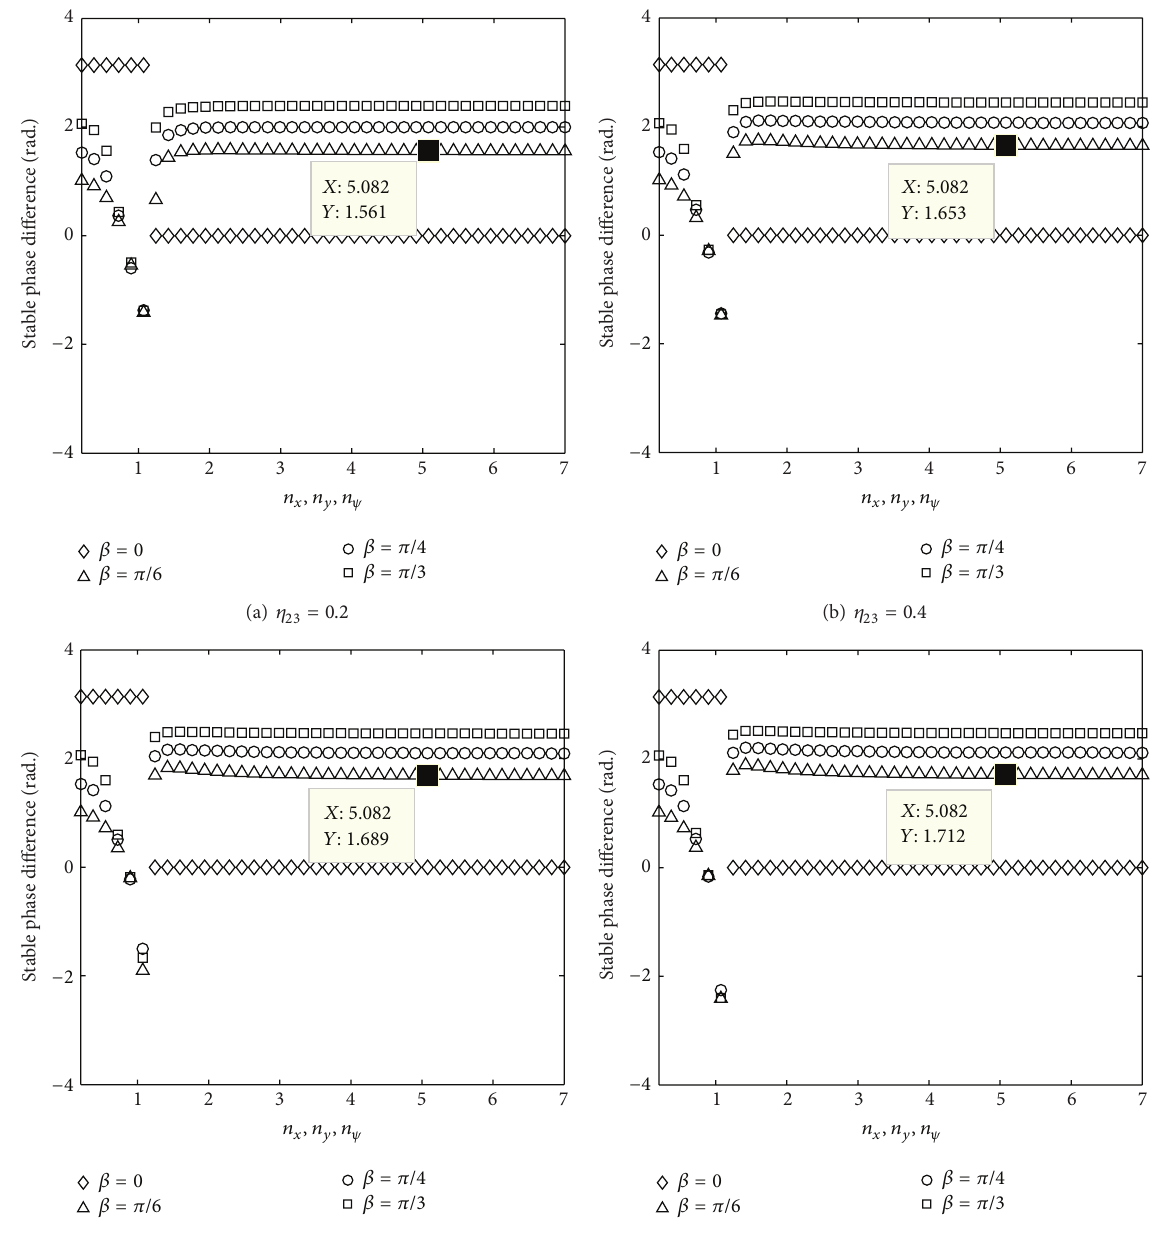
Figure 7: Stable phase difference for SBCWA and SACWA assuming the nonidentical mass of rotors and considering 𝜂 13 = 5 , 𝜂 23 = 1 , 𝜂 1 = 5 , = 2, 𝑟 = 0.08 , and 𝑙 = 0.6 : (a) 𝜂 𝑟 𝑜 𝑙